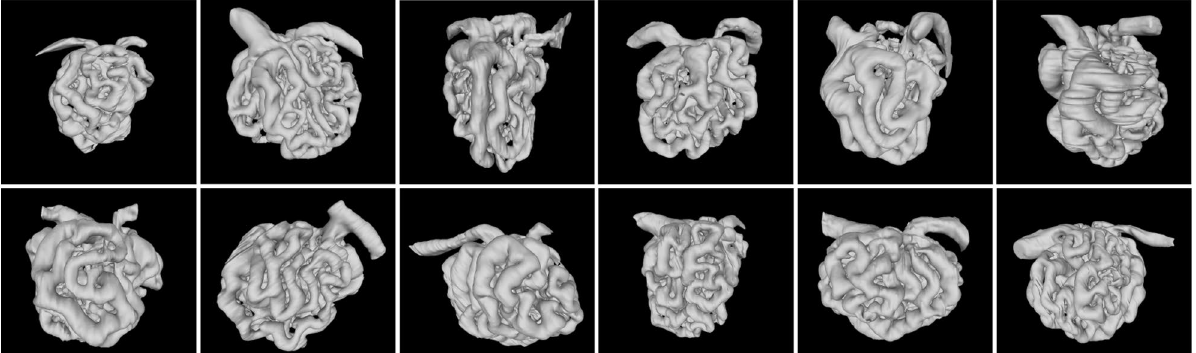
Figure 2. Montage of reconstructions of 12 glomeruli. Serial section data was segmented then 3D models were generated. They are shown from smallest (fewest nodes) to largest. Each glomerulus is oriented such that the vascular pole is up, the urinary pole is down, the afferent arteriole is on the left and the efferent arteriole is on the afferent arteriole entering the glomerulus can be identified because it branches from a large artery, whereas the efferent arteriole dives down into the medulla of the cortex. We collected serial sections of 12 glomeruli from 4 different mice. For each, the capillary lumen was segmented, reconstructed and rendered (Fig. 2); in the figure, the glomeruli are all oriented with the vascular pole up, urinary pole down, afferent arteriole to the left and efferent arteriole to the right.